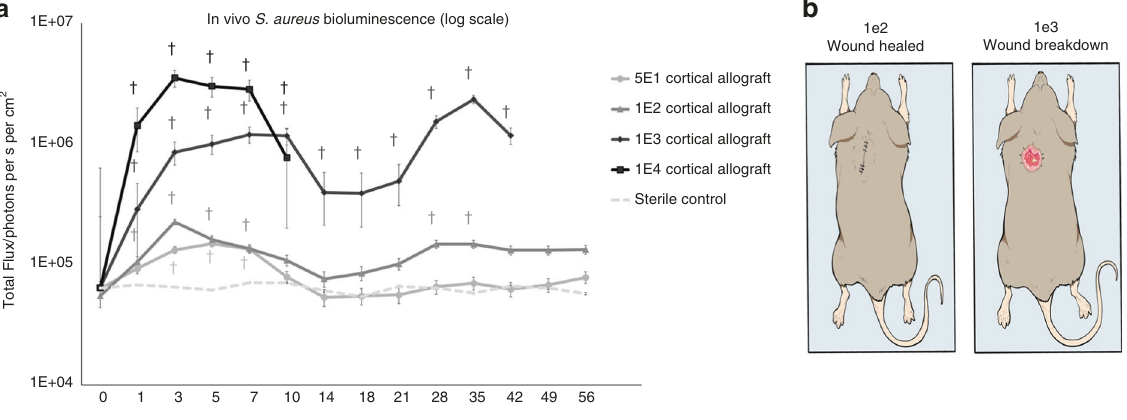
Fig. 1 Quantitative real-time bacterial burden on cortical allograft at increasing inoculums in a mouse model. a Measurement of bacterial burden using in vivo bioluminescence. S . aureus possessing the bioluminescent construct in a stable plasmid (Xen36) in four inoculums [5 × 10 1 , 1 × 10 2 , 1 × 10 3 , 1 × 10 4 colony-forming units (CFU)] or no bacteria as a control were inoculated on a cortical allograft implanted into mice. Bacterial counts as measured by in vivo S . aureus bioluminescence [total fl ux (photons per s per cm 2 )sem (logarithmic scale)]. Error bars represent standard error of the mean. † P < 0.05 compared to sterile in the mixed effects regression model using a group-by-time interaction term. Experiment was carried out through postoperative day (POD) 56 in order to identify an end plateau to the main curve of interest, the 1 × 10 2 inoculum. b Cortical allograft surgery. Mouse on left inoculated with 1 × 10 2 CFUs S . aureus had a healed surgical wound on POD21. Mouse on right inoculated with 1 × 10 3 CFUs S . aureus had wound breakdown necessitating euthanasia on